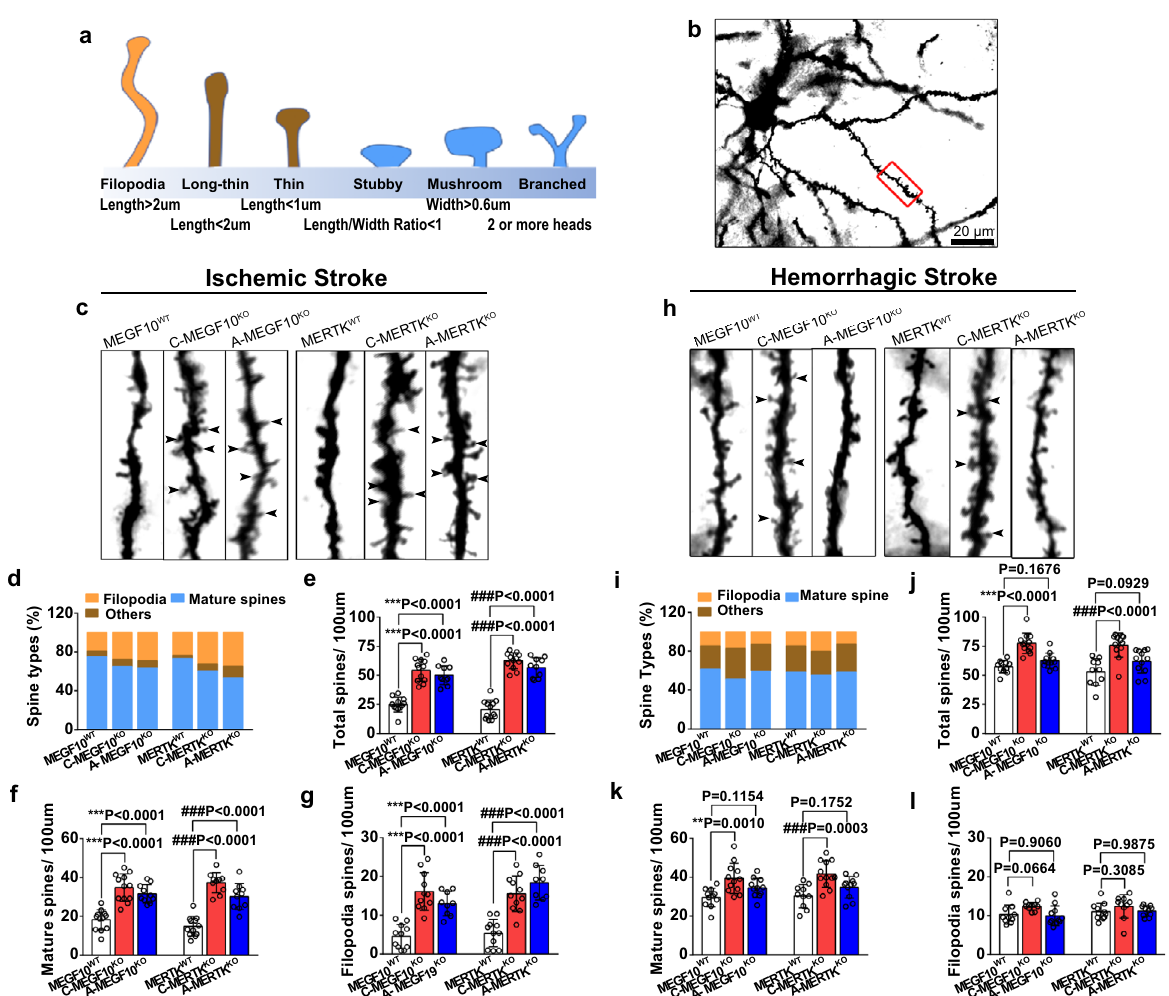
Fig. 7 Conditional knockout of MEGF10 and MERTK increased dendritic spine density in stroke mice. a Schematic diagram of different morphology of dendritic spines. b Low magni fi cation of Golgi staining images of neuron in the gliosis region. The experiment was repeated at least three times independently. Scale bar = 20 μ m. The red box indicates the region of high magni fi cation of spines in the secondary dendrite as shown in c and h . Representative images of dendritic spines and bar graph showed the percentage of each spine types ( d , i ) and the number of total spines ( e , j ), mature spines (including stubby, mushroom, and branched spines) ( f , k ) and fi lopodia spines ( g , l ) of MEGF10 WT , MERTK WT , C-MEGF10 KO , C-MERTK KO , A-MEGF10 KO , A-MERTK KO mice at 14 days after ischemic ( d – g ) and hemorrhagic stroke ( i – l ). Statistics are derived from 12, 12, 10, 12, 12, 10 slices ( e ), 12, 12, 10, 12, 10, 10 slices ( f ) and 11, 11, 9, 11, 11, 9 slices ( g ) (from left to right), n = 4 mice per group. Statistics are derived from 11, 12, 11, 10, 12, 12 slices ( j ), 11, 12, 11, 10, 12, 11 slices ( k ), and 10, 10, 11, 11, 10, 10 slices ( l ) (from left to right), n = 4 mice per group. One-way ANOVA followed by Dunnett ’ s test. Data are mean ±